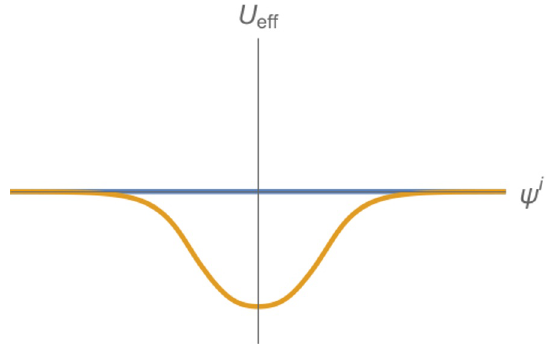
Figure 3 . The shape of the effective potential at finite temperature (orange) vs. zero temperature (blue). At zero temperature, the potential is flat and the components of the scalar background vev ψ i are free, while at finite temperature, the only stable configuration has all ψ i = 0 .